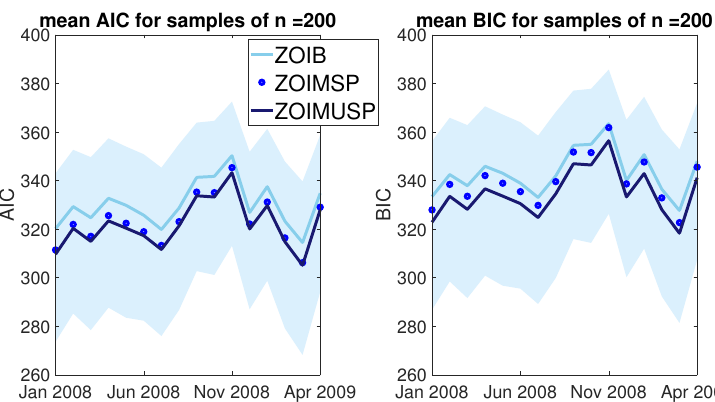
Figure 13. Bootstrap estimated mean of the AIC and BIC for the ZOIB, ZOIMSP, and ZOIMUSP models for a sample size of n = 200. The shaded area represents a 90% confidence interval for the mean of the ZOIMUSP